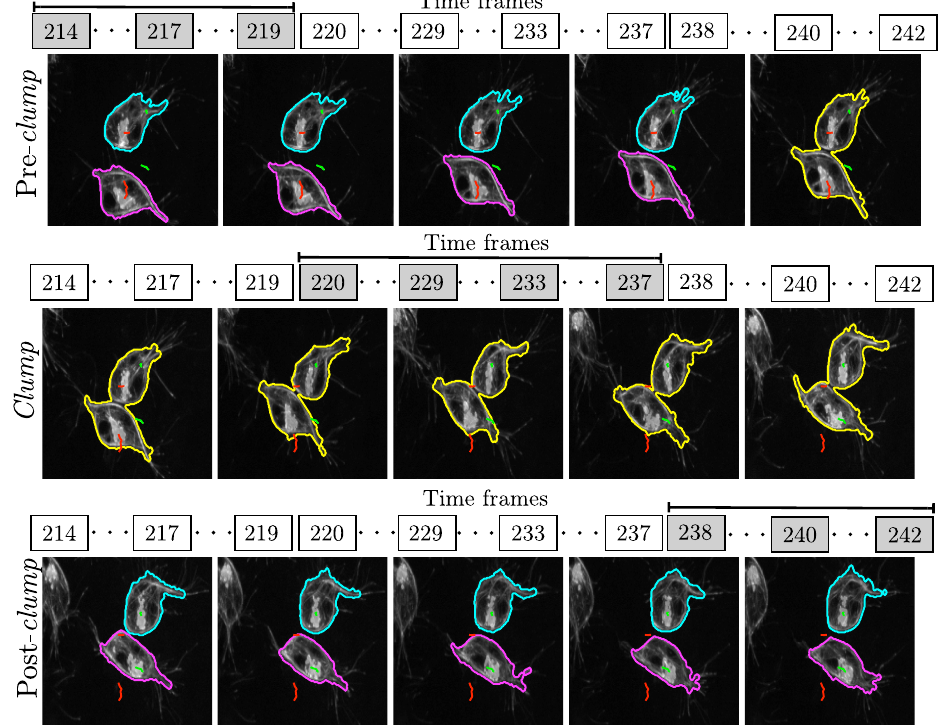
Figure 7. Representation of the migration of two cells as they form a clump . The perimeters of the individual cells are highlighted by cyan and magenta lines, whilst the perimeter of the clump is highlighted with a yellow line. Red lines indicate the movement of the individual cells before the clump is created, and a green line indicates the positions of cells after they separate. To show the duration of the clump , the number of time frames is shown above the images. In this case, the cells overlap and form the clump for 18 frames, which is equivalent to 180